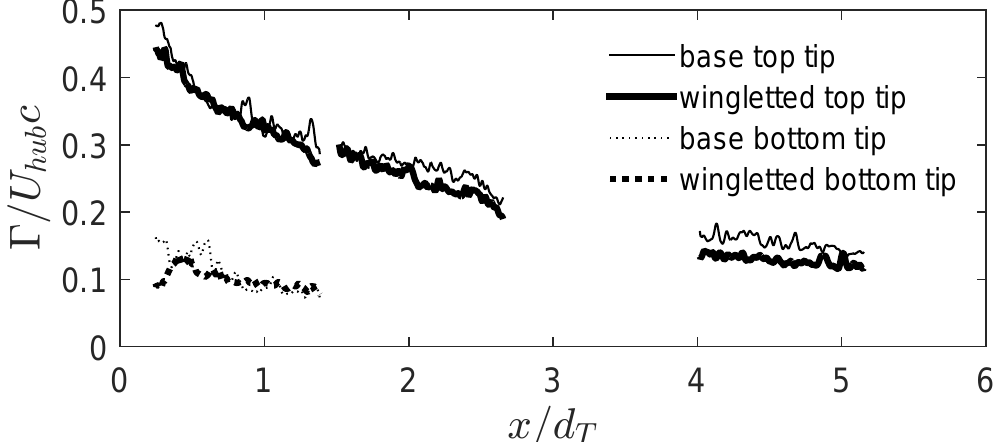
Figure 12. Instantaneous velocity field fluctuations overlaid on λ identification of tip vortices.